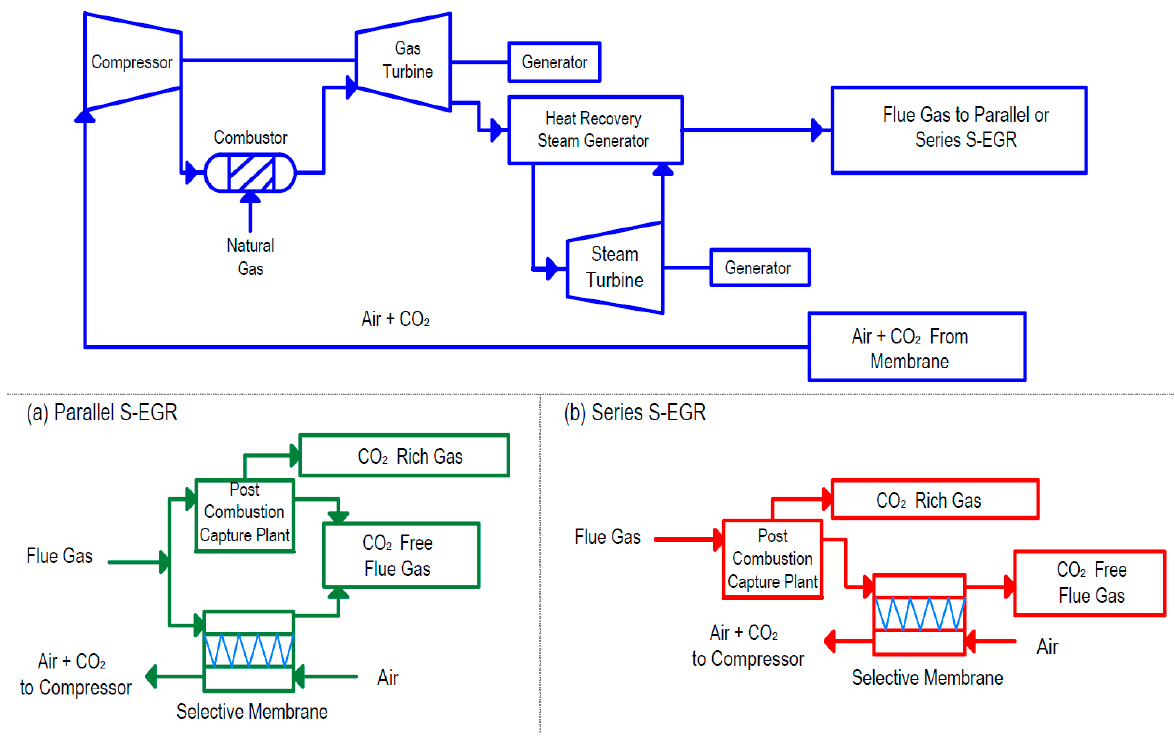
Figure 4. (a) Parallel and (b) series configurations of the selective EGR cycles (adapted from [73]). Figure 4. ( a ) Parallel and ( b ) series configurations of the selective EGR cycles (adapted from [73]). (a) parallel; (b) series . ( a ) parallel; ( b )